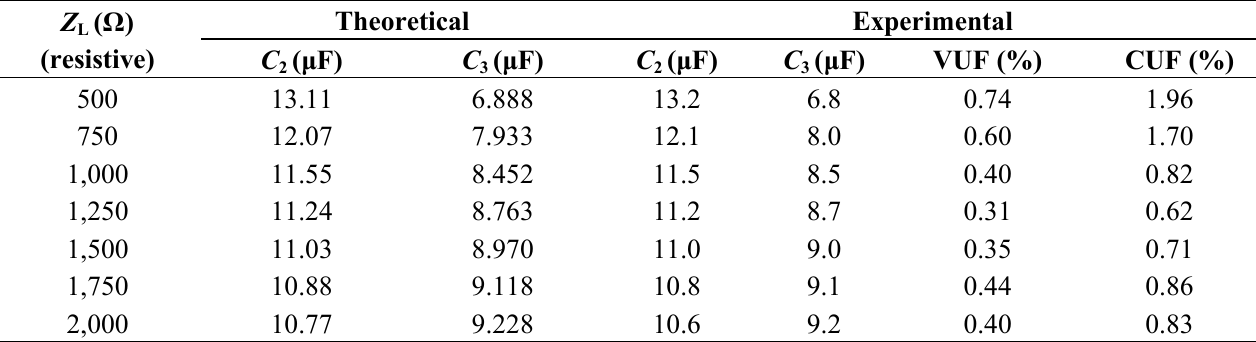
Table 4. Theoretical and experimental capacitance values and measured VUF and CUF for pure resistive